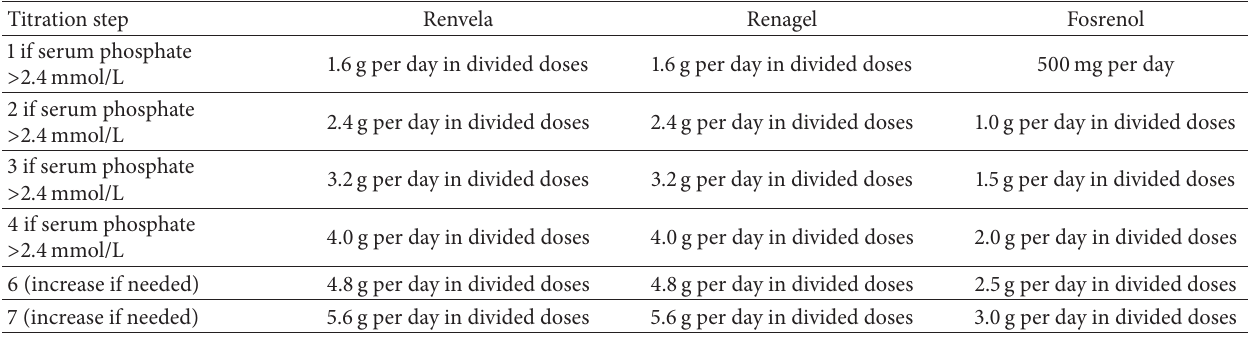
Table 4: Dosing schedule in the HRG.